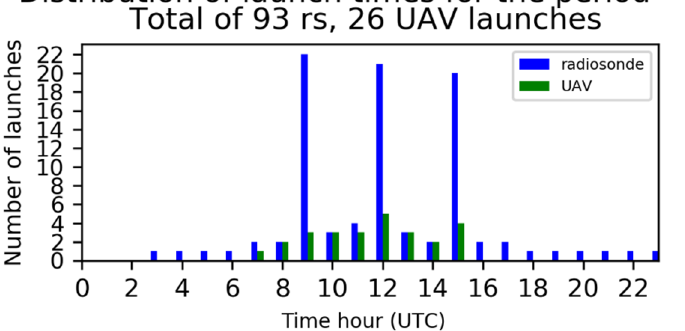
Figure 2. Distribution of radiosonde (blue) and UAV (green) launch times during the inter-comparison period.